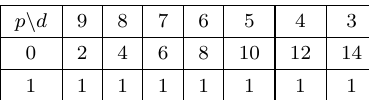
Table 23 . Number of F-branes in the p -brane multiplet in d -dimensions [10]. p \ d